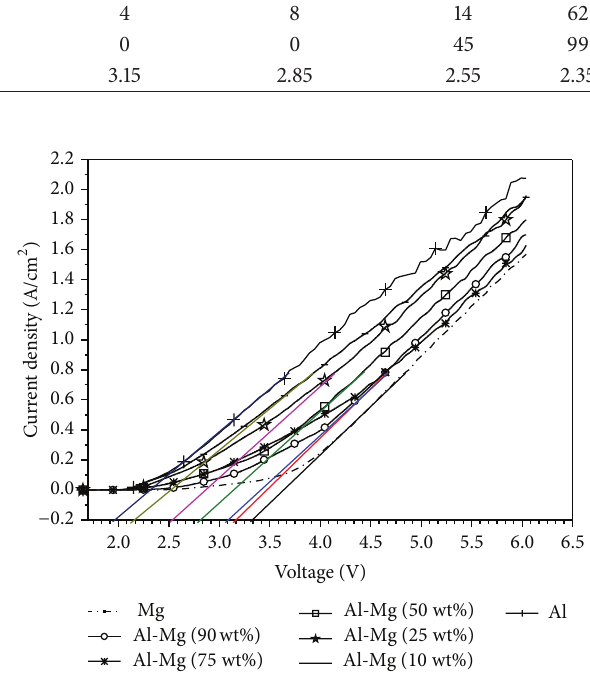
Table 1: The electrolytic performance of the experimental electrodes. Property